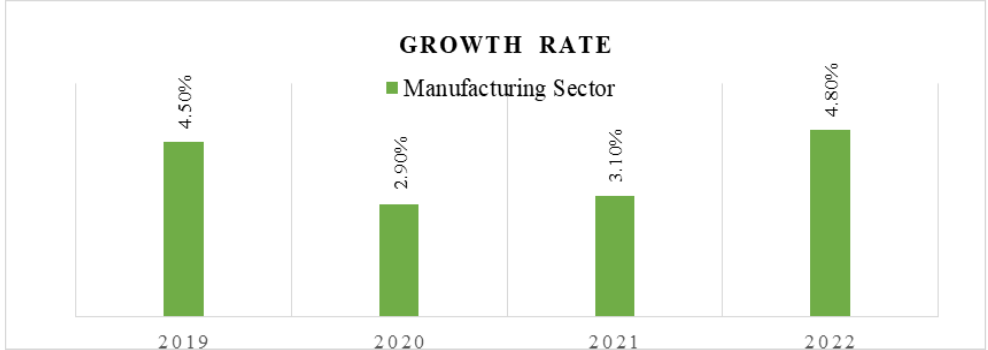
Figure 1. The percentage of growth rate of the Malaysian manufacturing sector for 2019, 2020, 2021, and 2022; Source: Department of Statistics Malaysia (2021) and Department of Statistics Malaysia Official Portal (2022)